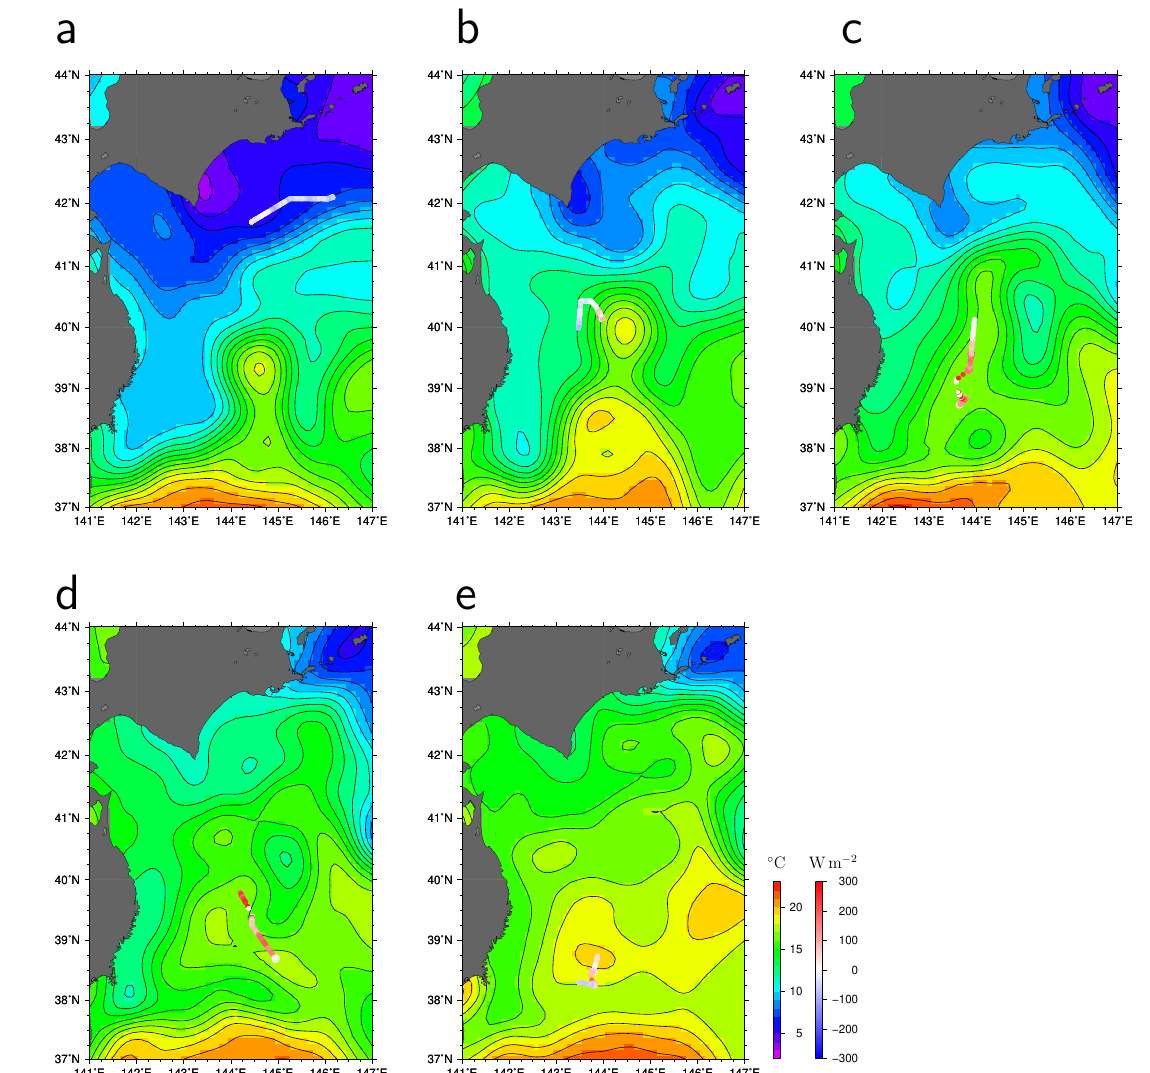
Figure 6. The Wave Glider tracks during the period shown by letters a–e in Figure 5, which correspond to panel letters of this figure. Values of turbulent (latent plus sensible) heat flux (Wm − 2 ) are shown by colors of the WG tracks. Maps of SST ( ◦ C) are satellite-observed values on ( a ) 13 May, ( b ) 25 May, ( c ) 7 June, ( d ) 15 June, and ( e ) 22 June 2022. The contour intervals of SST are 1 ◦